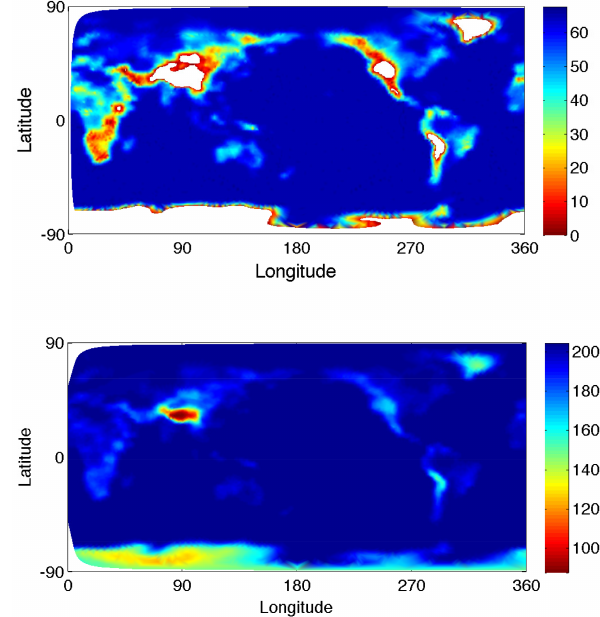
Figure 7. Fair weather electric potential (kV) along the 1.5km (top) and 6km (bottom) constant height surface above sea level. In the top figure, the regions in white are the intersection of the 1.5km constant height surface with the Earth’s